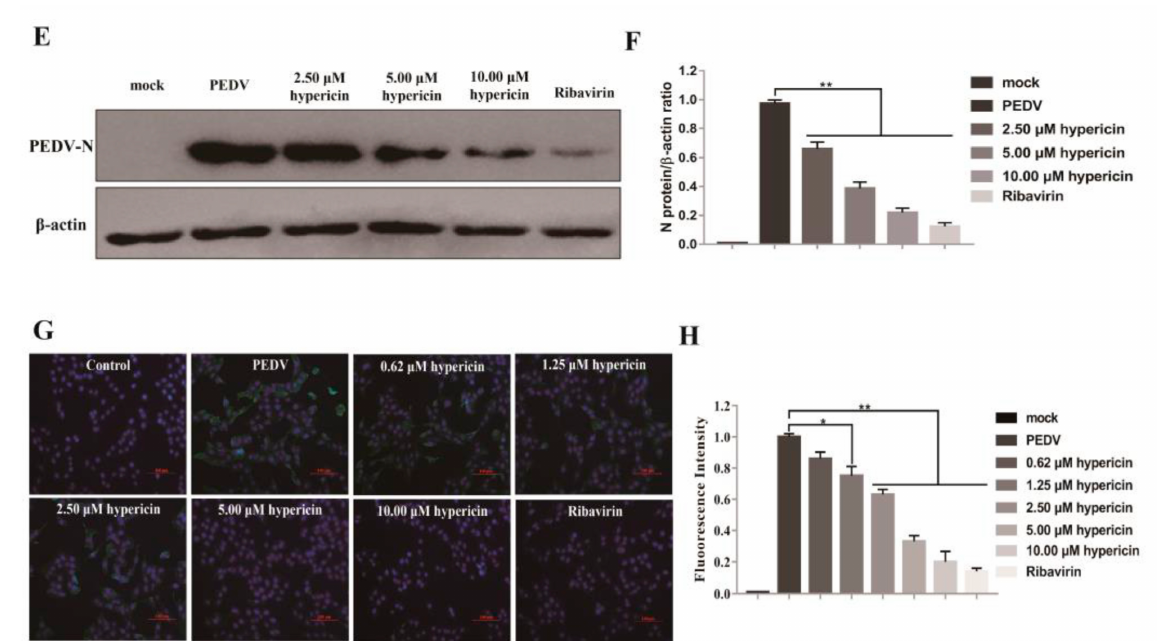
Figure 1. Hypericin in PEDV-infected cells. ( A ) An overview of hypericin pre-treatment and post-treatment in PEDV- infected Vero cells. ( B ) Cell viability upon hypericin treatment in Vero cells. Cells were treated with the indicated doses of hypericin for 48 h, and the cell viability was further measured by CCK-8 assay. All CCK-8 values were normalized to the 0 µ g/mL, which represents 100% cell viability. ( C ) Vero cells were infected with PEDV at MOI 0.1 with hypericin pre-treatment and/or post-treatment at the concentrations of 2.5 µ M, 5.0 µ M, and 10.0 µ M. The ribavirin treatment (200 µ M) was a positive control to block PEDV entry or replication. The cells were processed for RNA extraction; viral N gene was quantified by qRT-PCR, using the primer sets described in Materials and Methods. The expression levels of viral N gene were normalized to those of β -actin, and data represent average amounts relative to the PEDV-infected cells with 0.05% ( v / v ) of DMSO treatment. ( D ) Culture supernatants were examined by TCID 50 . Results were expressed relative to the PEDV-infected cells with 0.05% ( v / v ) of DMSO treatment. ( E ) Proteins were separated by SDS-PAGE, and Western blot membranes were probed with an antibody against either PEDV N or GAPDH. ( F ) The N protein expression in each sample was quantified and normalized to the GAPDH signal. Results were expressed relative to the PEDV-infected cells with 0.05% ( v / v ) of DMSO treatment. ( G ) The post-treatment of hypericin in PEDV-infected cells at the concentrations of 0.625 µ M, 1.25 µ M, 2.5 µ M, 5.0 µ M, and 10.0 µ M. Cells were processed for immunofluorescence using antibodies against PEDV N protein and DAPI staining. ( H ) The percentage of viral infected cells was calculated by counting the cells with PEDV N-positive signal and dividing it by the number of DAPI-positive. For each condition, we chose at least three views with more than 300 DAPI-positive cells and triplicated them to get the standard deviation. All data are represented as mean ± SD of at least three independent experiments. Student’s t -test was used to evaluate statistical differences, and a p < 0.05 was considered significant with *, and ** showed p <